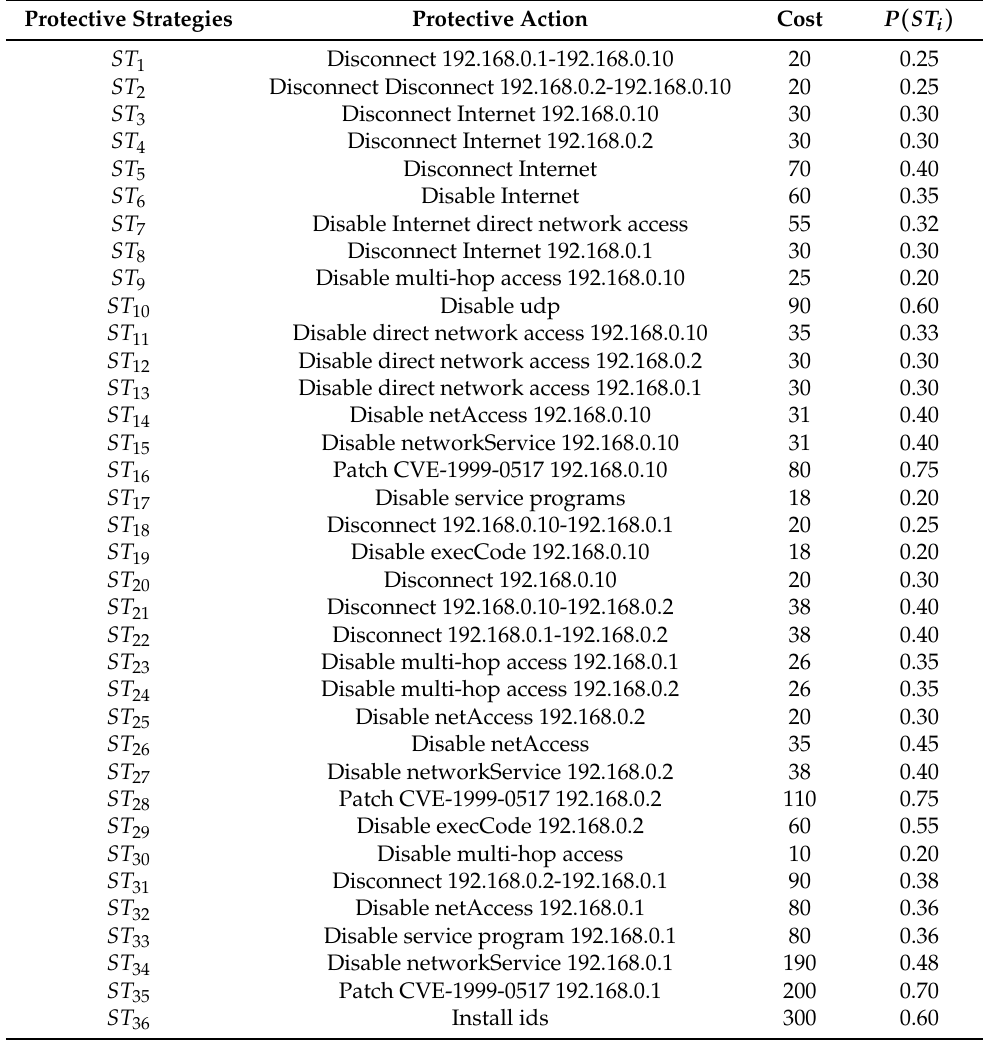
Table A1. Detailed parameters of protective